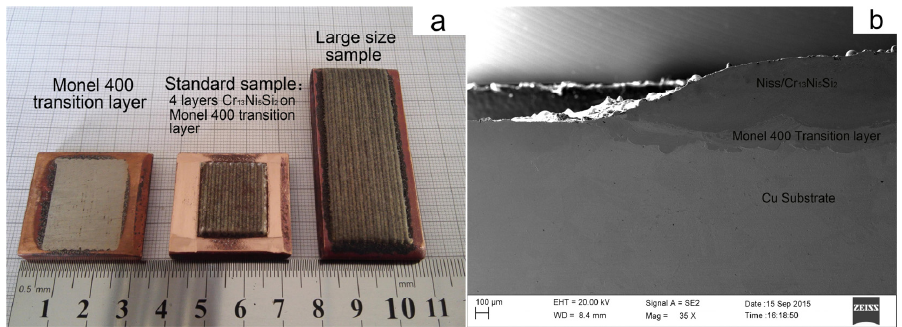
Figure 2. Macro-appearance of samples by PLIC: ( a ) Monel400 transition layer and Cr 13 Ni 5 Si 2 -based composite coating; ( b ) cross-sectional view of the coating.